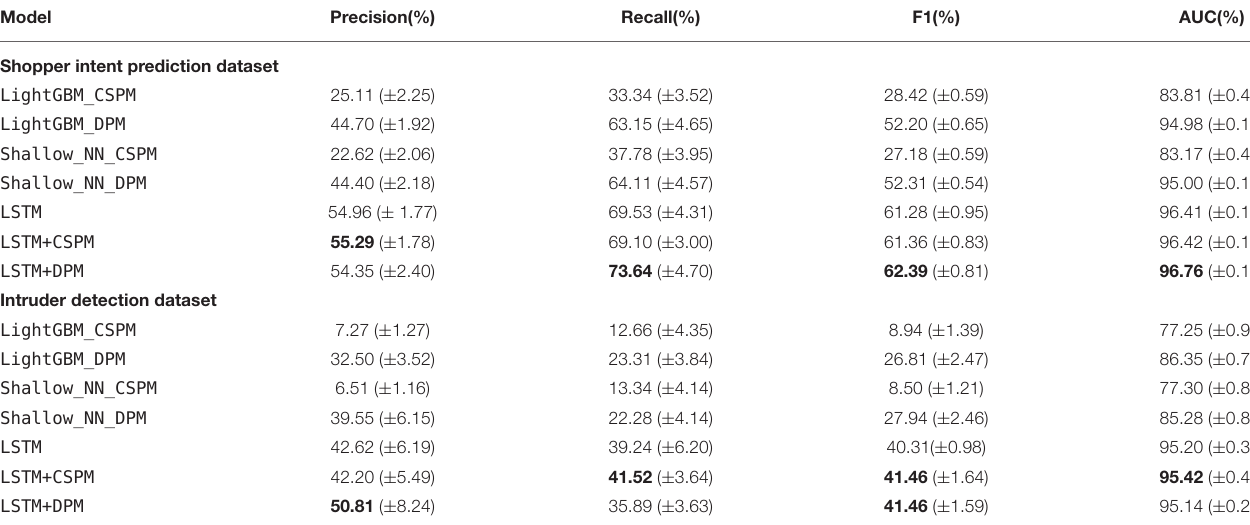
TABLE 5 | Comparison of averaged prediction performance by different methods over 10 random Train-Test splits. Model